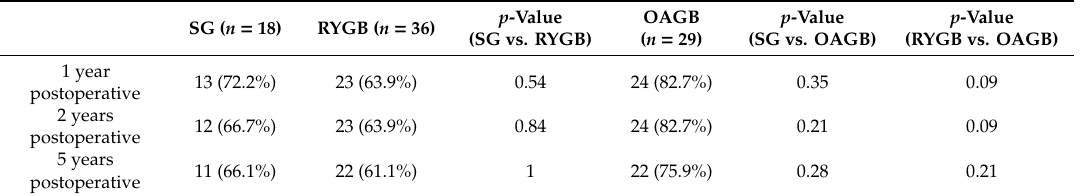
Table 5. Remission of T2D in patients under preoperative insulin treatment between